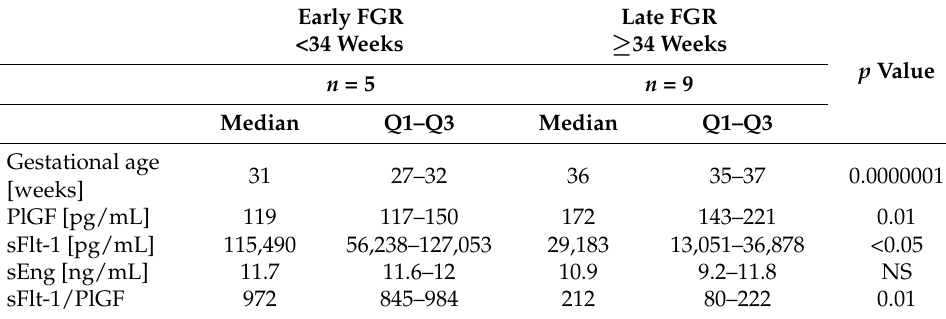
Table 10. Comparison of the results in early and late